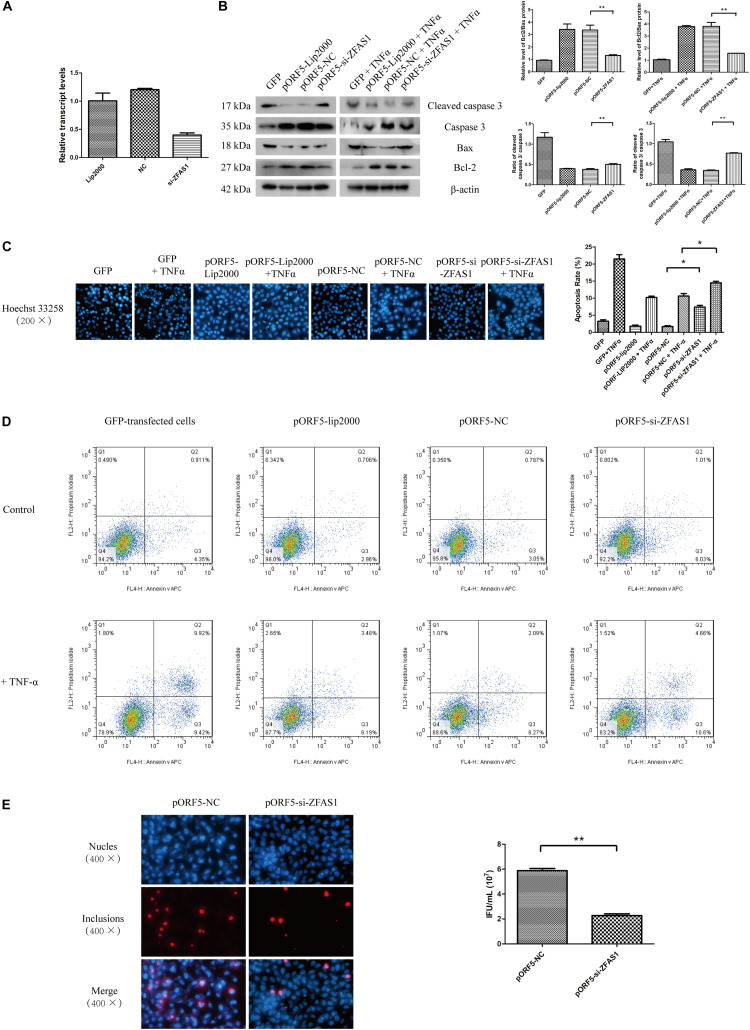
Inhibition of ZFAS1 reduces the anti-apoptotic effect of pORF5 and the infectivity of C. trachomatis.
(A) Knockdown of lncRNA ZFAS1. (B) The detection of apoptosis in ZFAS1-interfered cells after the apoptotic induction by TNF-α. (C) The apoptotic rate (right panel) was detected by Hoechst staining (left panel). (D) The apoptotic rate was detected by FACS. (E) Infectivity of C. trachomatis was tested after the knockdown of ZFAS1. ∗P < 0.05; ∗∗P < 0.01.